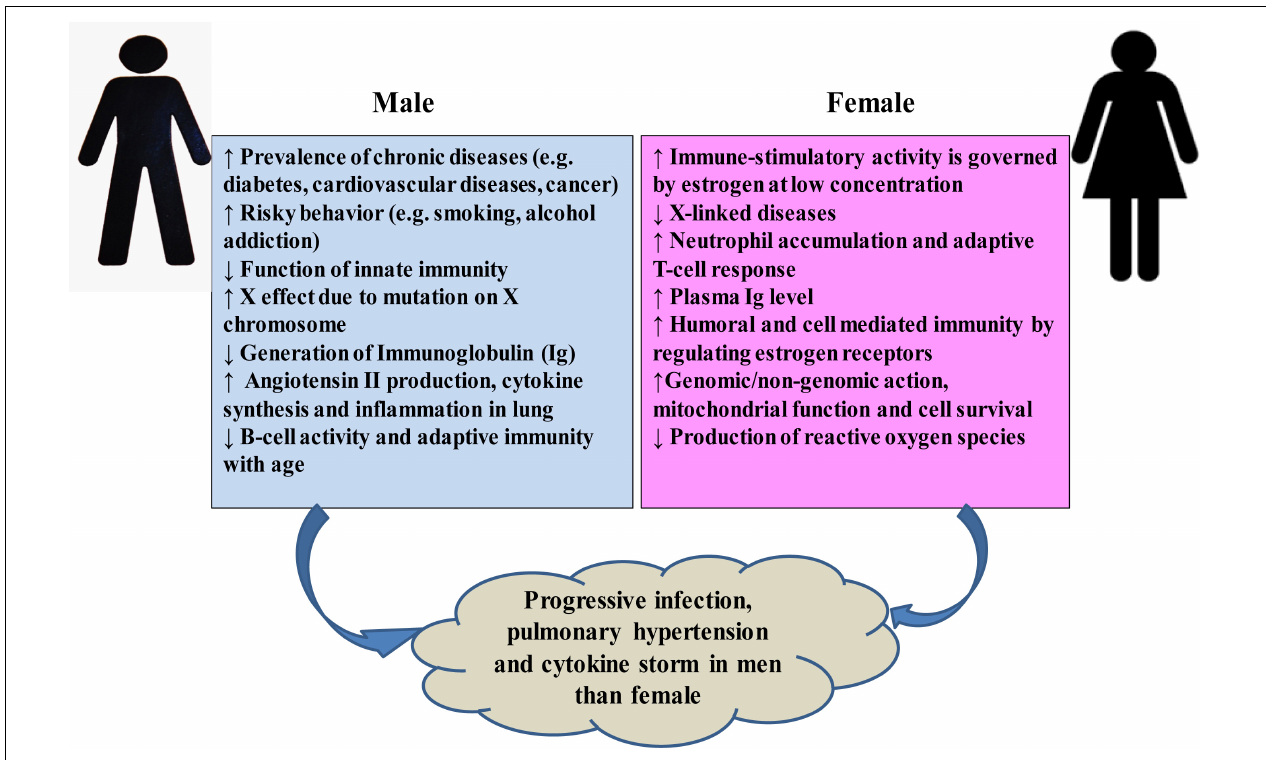
FIGURE 6 | Possible sex-specific phenomena that may affect host response and lead to the progression of COVID-19 and post-complications.